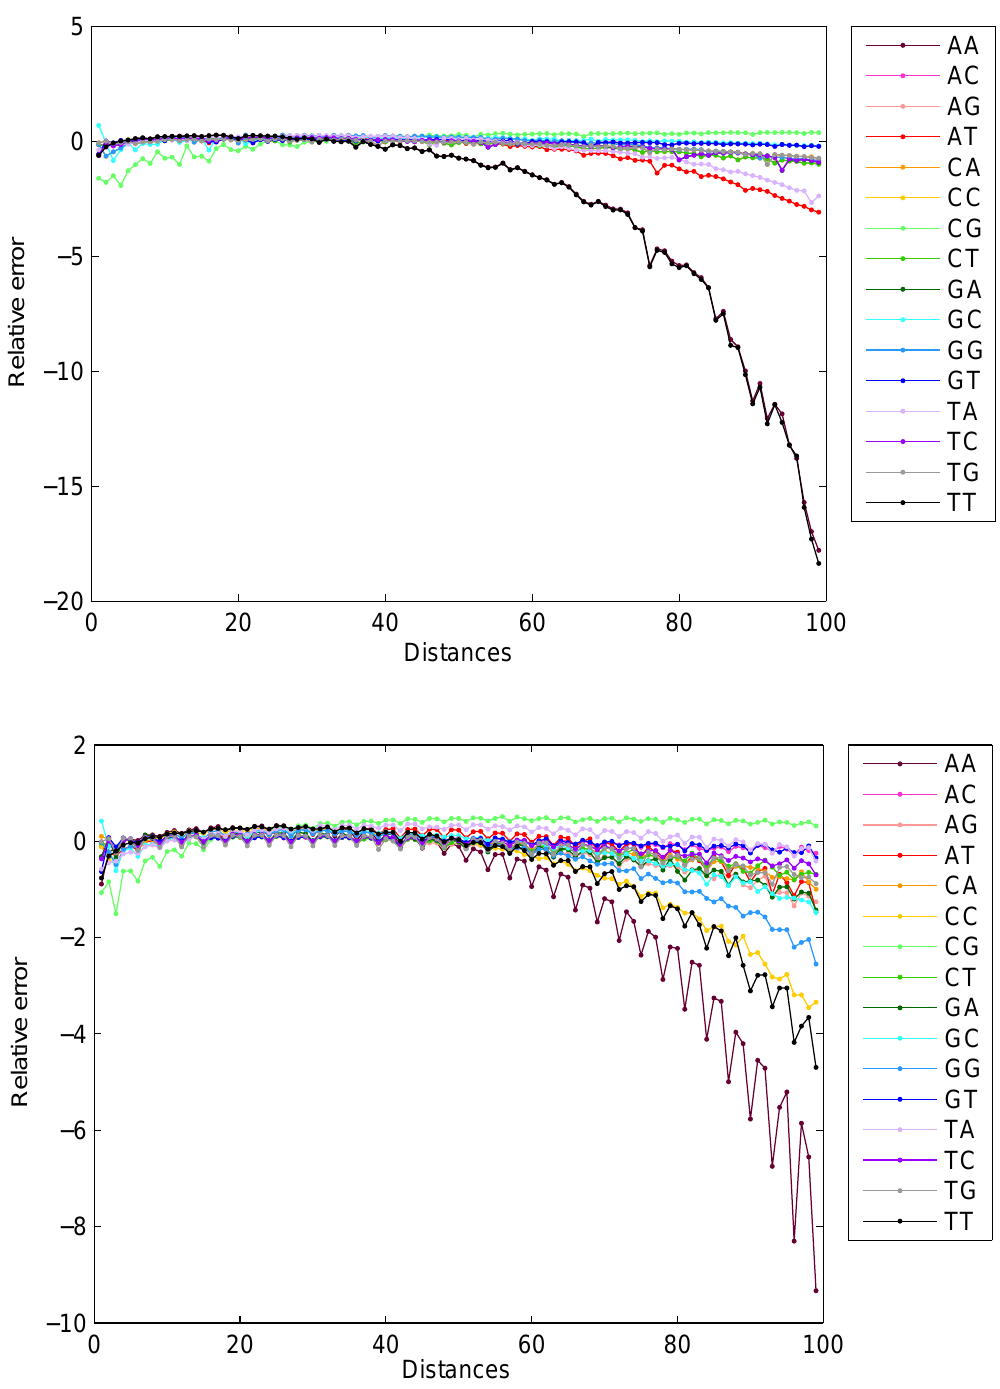
Figure 2: Relative error, r ( k ) , for the first 100 distances of each dinucleotide in the whole-genome (top) and protein-coding (bottom) distributions. Note the singular behavior of the AA and TT dinucleotide